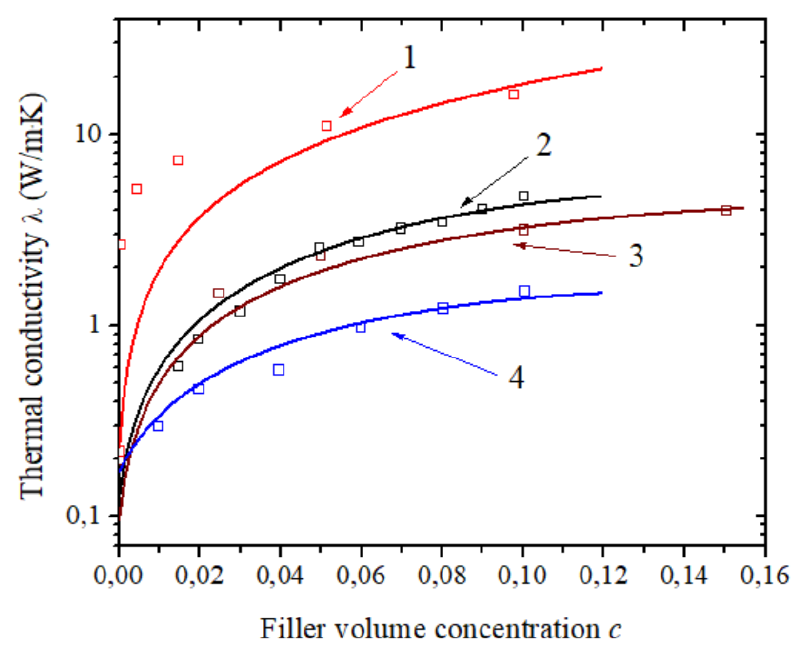
Figure 12. The thermal conductivity of the nanocomposite vs. the volume concentration of the graphene nanofiller calculated in [102] and measured for different graphene size in various works: 1—